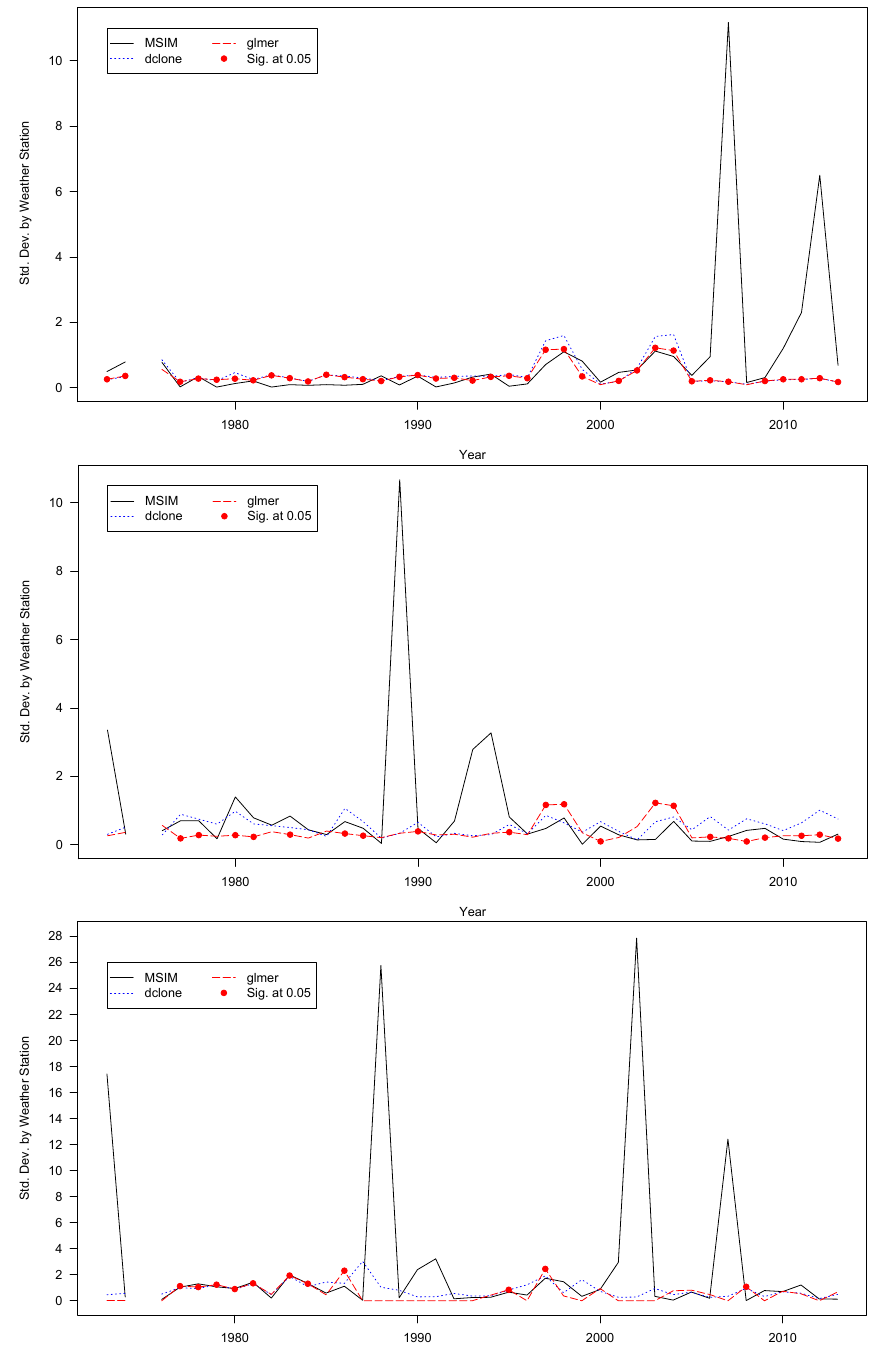
Figure 2. Top panel: weather station standard deviation estimates for logit-normal models with light Indian rainfall (0 <x ≤ 64.4mmday − 1 ) as the response from 1973–2013. Estimates over time indicate variability near 0, however, most of the glmer estimates are signifi- cant at the 0.05 level. Middle panel: weather station standard deviation estimates for logit-normal models with moderate Indian rainfall (64.4 ≤ x < 124.4mmday − 1 ) as the response from 1973–2013. Approximately half of the glmer estimates are significant at the 0.05 level. Bottom panel: weather station standard deviation estimates for logit-normal models with extreme Indian rainfall ( ≥ 124.4mmday − 1 ) as the response from 1973–2013. Approximately one-quarter of the glmer estimates are significant at the 0.05